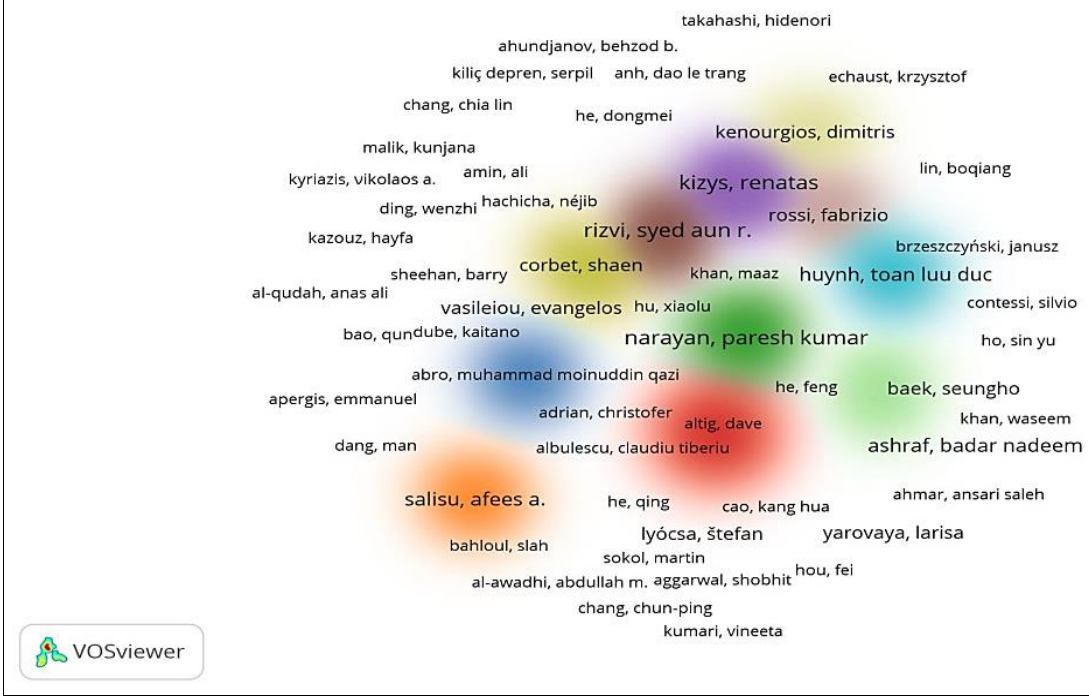
Figure 6. Cluster Density